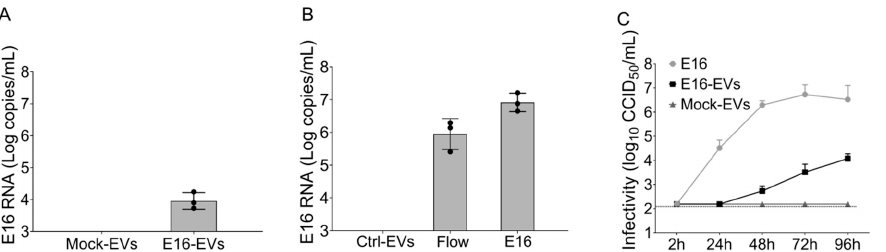
Figure 4. EVs released from E16-infected EndoC- β H1 cells transmit productive enterovirus infection to recipient cells. ( A ) Real-time qPCR analysis of enterovirus RNA content in immunopurified EpCAM-positive EVs from mock (Mock-EVs) or E16-infected EndoC- β H1 cells (E16-EVs). ( B ) EVs derived from mock-infected EndoC- β H1 cells were exposed to free E16 and re-isolated by the immunomagnetic selection of EpCAM-positive EVs. Enterovirus RNA content was analyzed by qPCR in EpCAM-selected EVs (Control-EVs) and flow-through samples. Cell-free virus (E16) was used as a positive control. ( C ) Naïve EndoC- β H1 cells were incubated with EVs from E16-infected EndoC- β H1 cells (E16-EVs) or mock-infected cells (Mock-EVs). EndoC- β H1 cells infected with the cell-free virus (E16) at an MOI of 0.00001 were used as a positive control. At 2 hpi, cells were washed off, and cultured in fresh Dulbecco’s Modified Eagle Medium (DMEM) medium for further 96 h. Total EndoC- β H1 cell lysates (cells plus supernatants) were collected at different time points and viral titers determined by end-point dilution on GMK cells. Dotted black lines indicate the limit of detection. Data are representative of three independent experiments, with each measurement performed in triplicate (mean ± SEM).